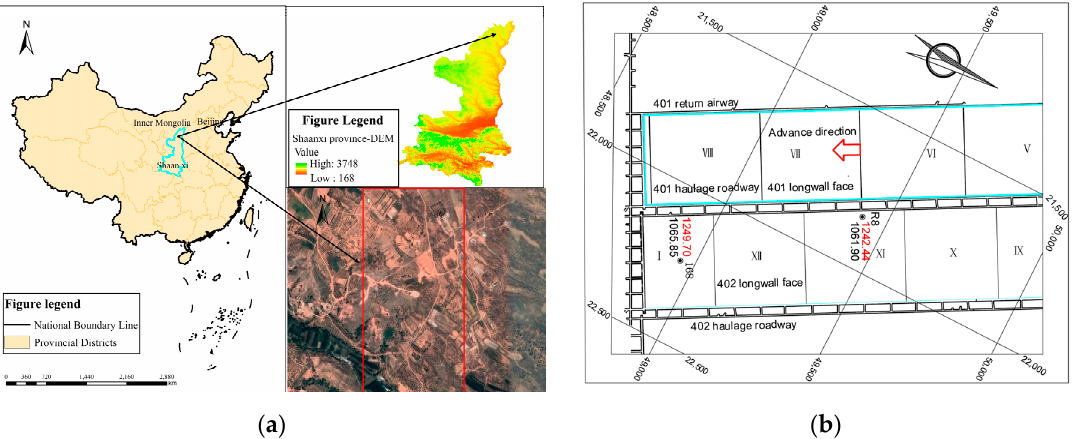
Figure 6. Location of Shangwan Mine and 401 working face layouts: ( a ) Location of Shangwan Mine; ( b ) 401 working face layouts.